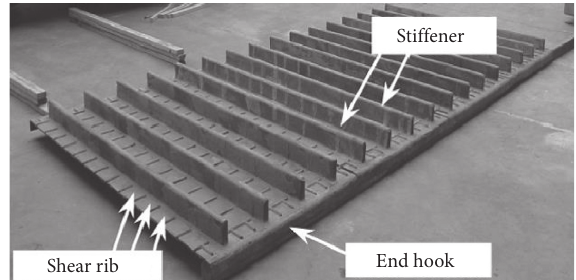
Figure 3: GFRP panel of the hybrid deck proposed by